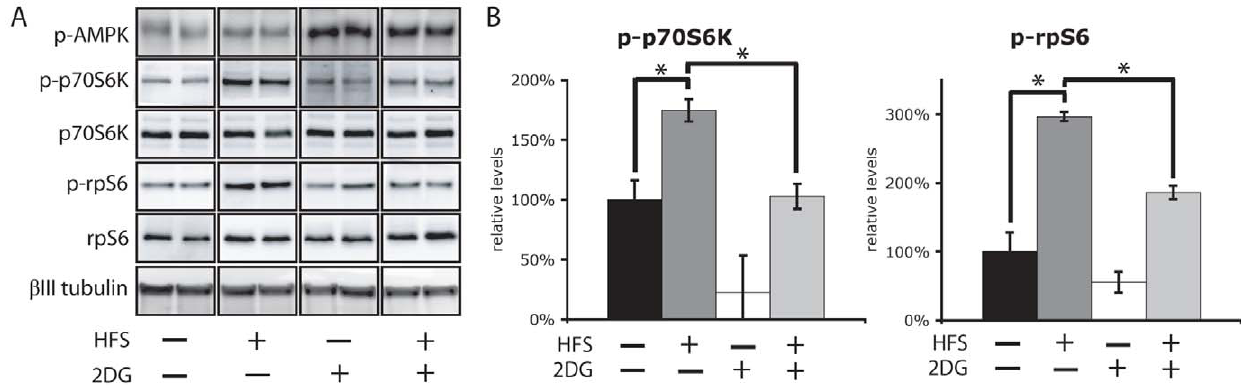
Figure 2. AMPK activation represses the mTOR pathway. 10 mM 2DG inhibits the hippocampal mTOR pathway. A) HFS was delivered to the Schaeffer Collateral pathway of slices that had been incubated in the presence or absence of 10 mM 2DG for 30 minutes. Slices were then subjected to western blot analysis using anti-phospho-Thr389-p70S6K, anti-p70S6K, anti-phospho-Ser235/236-rpS6 or anti-rps6 antibody. Representative western blots of duplicate lanes and quantification (B) of 12 samples per condition are shown. Error bars show standard error of the mean (s.e.m). *p , 0.05.